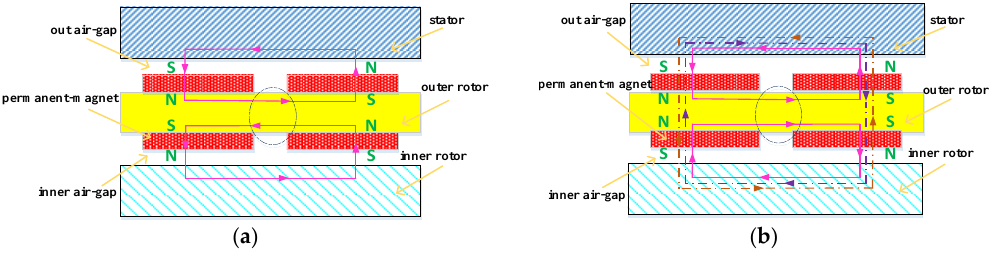
Figure 9. The diagram of the magnetic flux flow in the CSPM motor: ( a ) consistent magnetization direction of the permanent-magnet; ( b ) opposite magnetization direction of the permanent-magnet.